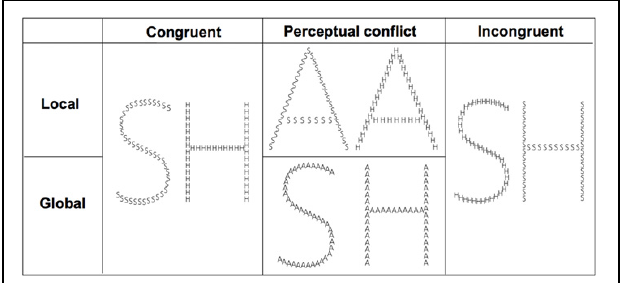
FIGURE 1 | Examples of